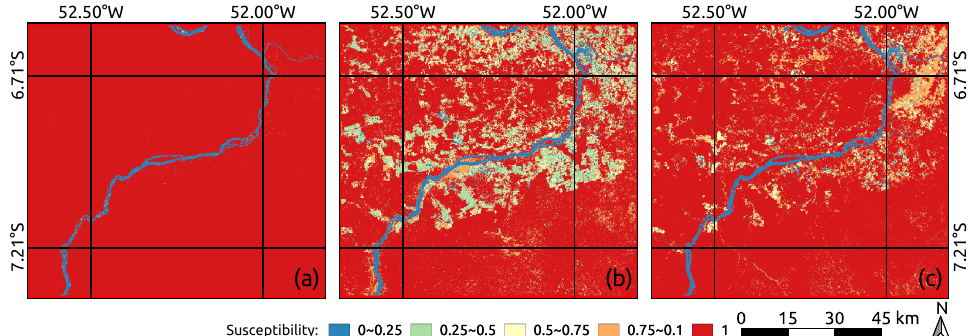
Figure 7. Fire susceptibility maps for Area 1 with IF method as anomaly detection model. Subfigures ( a – c ) refer to mappings based on the “analysis period” of epochs I, II, and III, respectively.